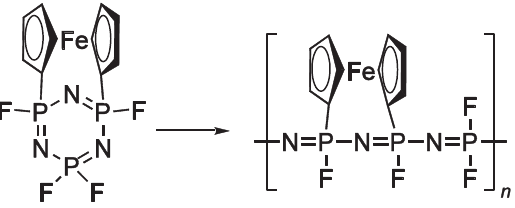
An alternative method to increase the ring strain is shown in Figure 68. Figure 68. Synthesis of a polyphosphazene with a ferrocene side